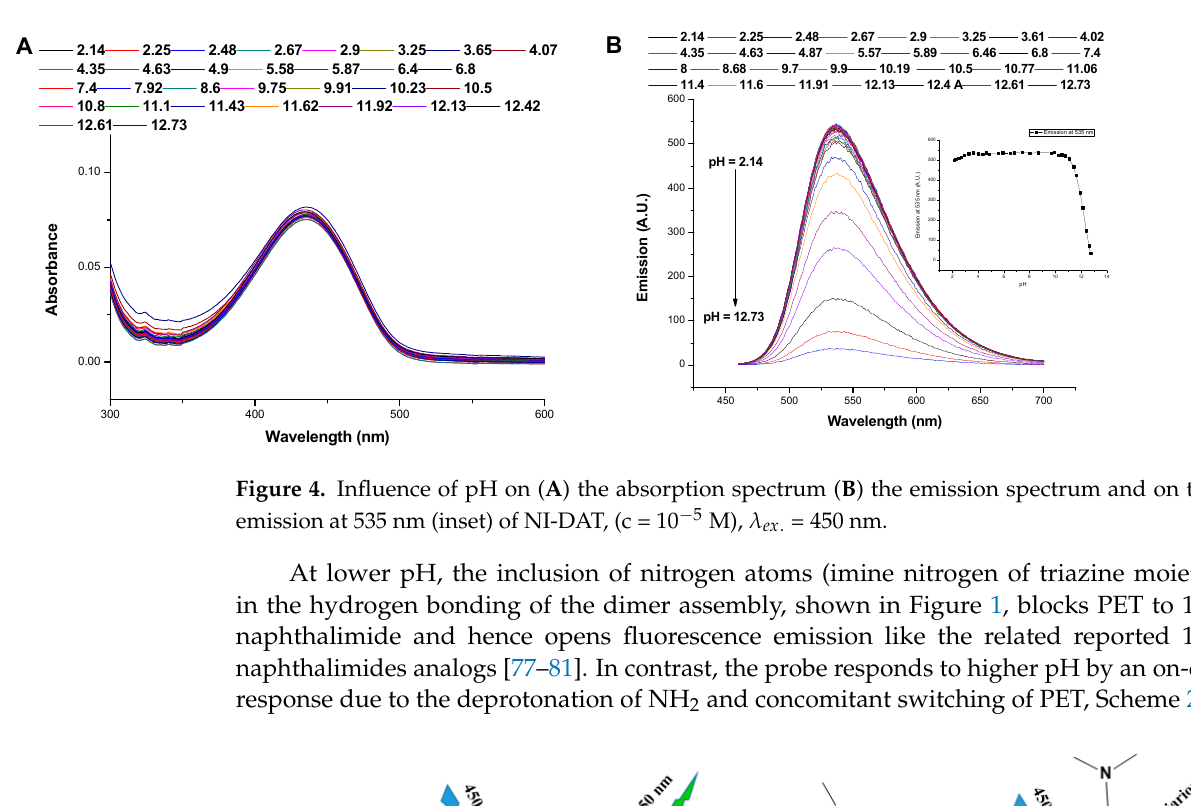
Scheme 2. Proposed PET mechanism at different pH.